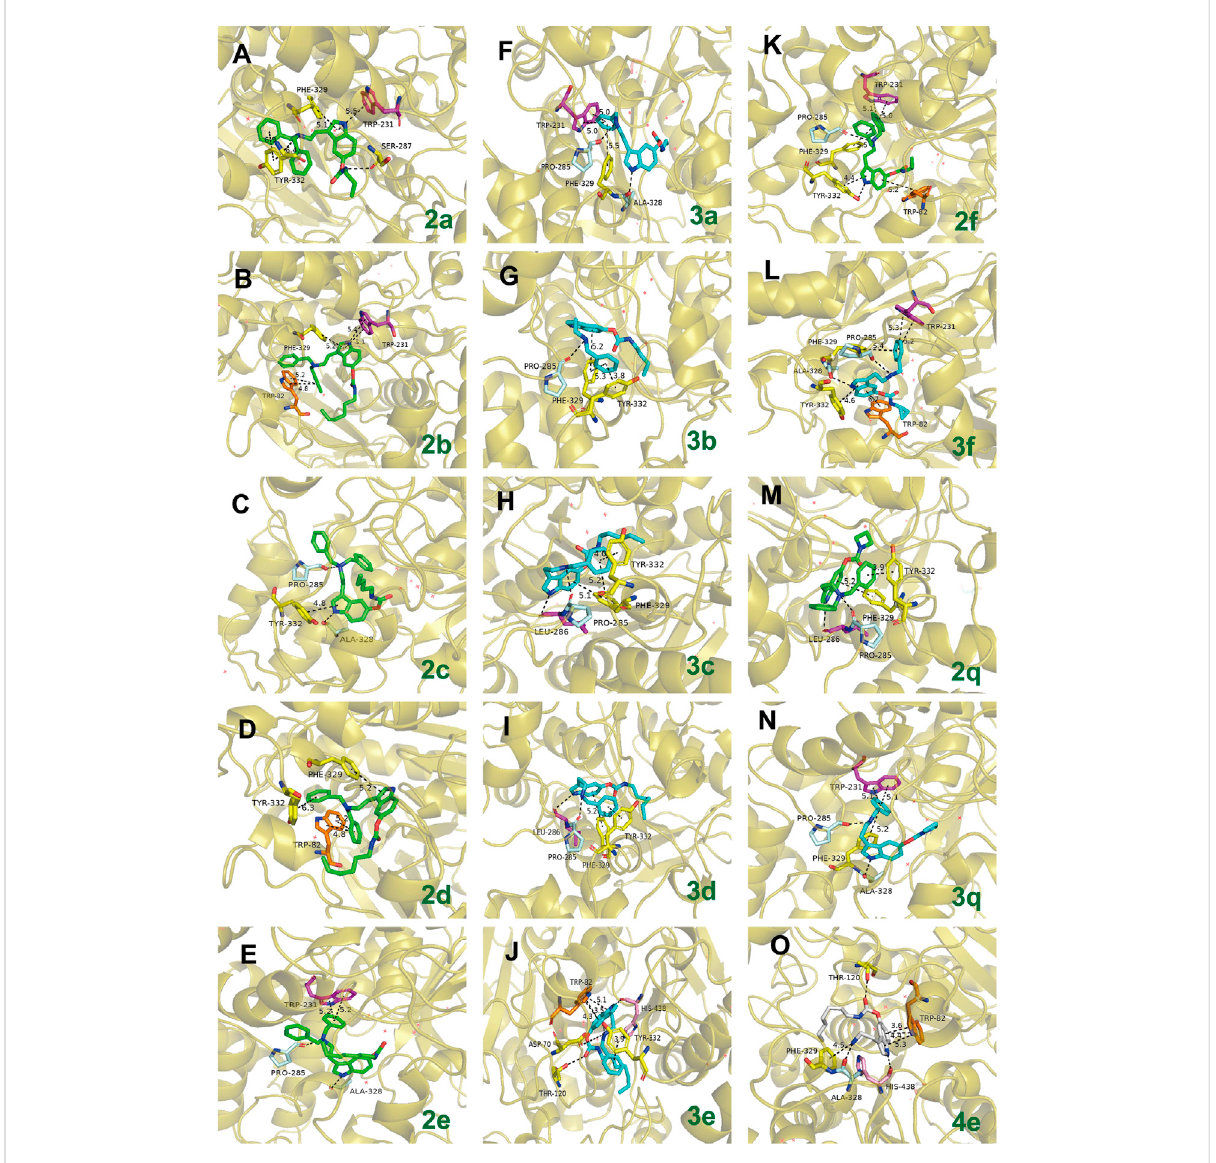
FIGURE 5 The possible binding mode for the selected compounds in the BuChE (PDB code: 4TPK) binding sites (A – O) . The 3D images of selected compoundsbindtoBuChEpolishedbyPymol(http://www.pymol.org).Residuesoftheacyl-bindingpocket(Leu286,Trp231)areshowninmagenta, the CAS (His438) is shown in pink, the choline-binding site (Trp82) is shown in orange, the residues of PAS (Asp70, Thr120, Tyr332, and Phe329) are shown in yellow, and parts of the side cavity (Pro285, Ala328) are in pale cyan. The dashed lines indicate hydrogen bond interaction, π – π stacking interactions, or π – cation